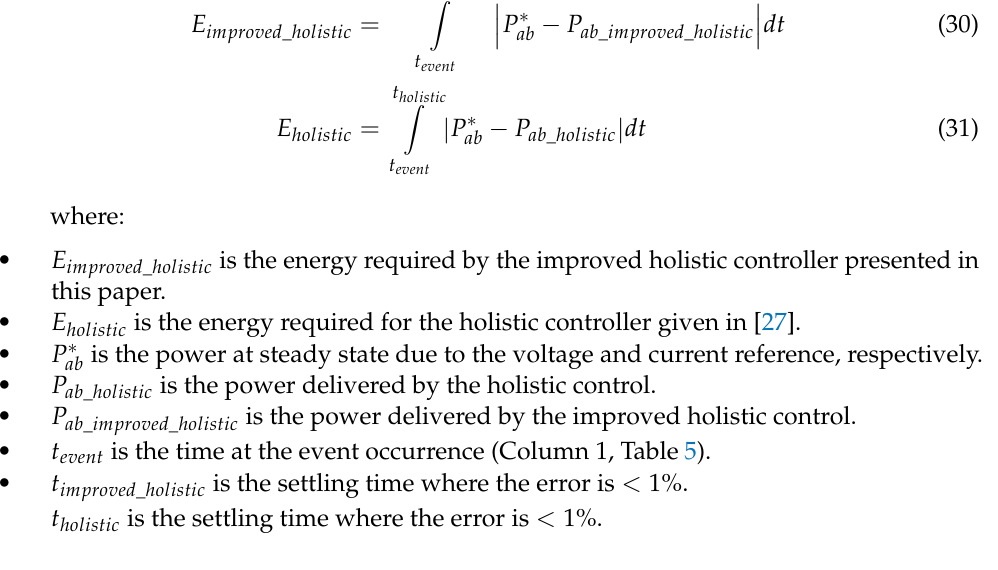
Table 5. Test protocol for improved holistic and holistic closed-loop system comparison. Change Value Holistic Energy Time (s) Type of Event According to the Event